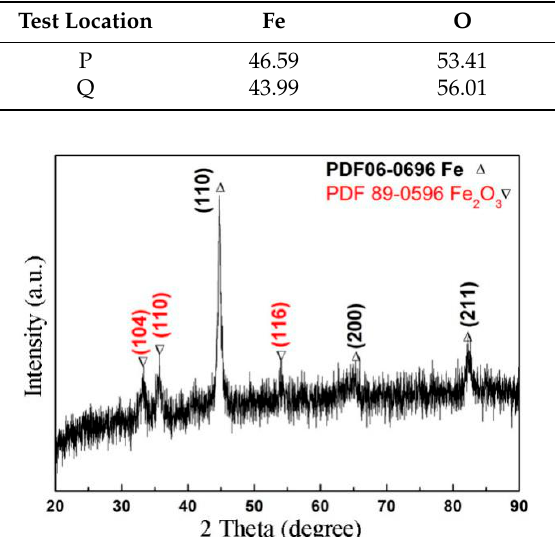
Table 2. Chemical components of the worn surface (at.%).